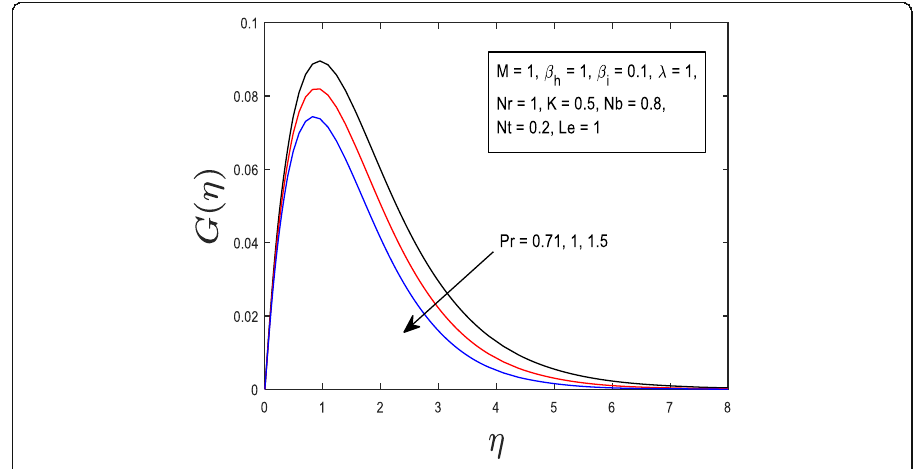
Fig. 21 Graph of cross flow velocity for various values of Pr